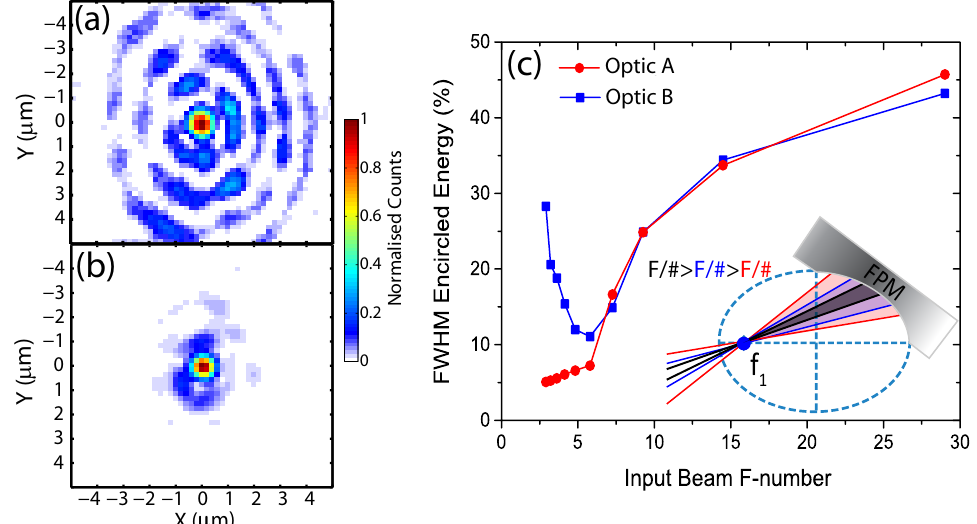
Figure 4. Typical measured spatial-intensity distributions of the optimised focal spot formed by: ( a ) Optics A; and ( b ) Optics B. ( c ) Plot quantifying the change in output focal spot FWHM encircled energy as a function of the input beam F-number. The red and blue curves represent results obtained for Optics A and Optics B, respectively. Insert: schematic showing the concept of varying the input beam F/# and the resultant change in the illuminated area on the FPM surface (black corresponds to the largest F/#, and red corresponds to the